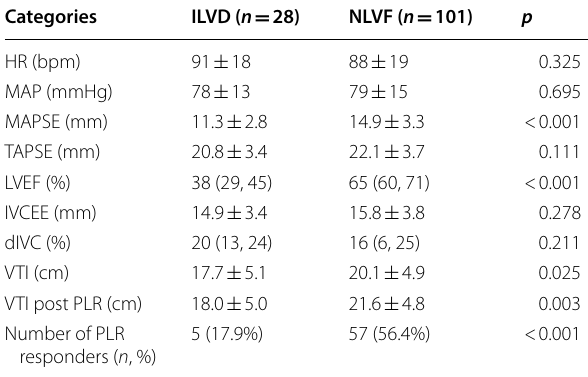
Table 1 General characteristics Table 2 Hemodynamic and echocardiographic parameters of the